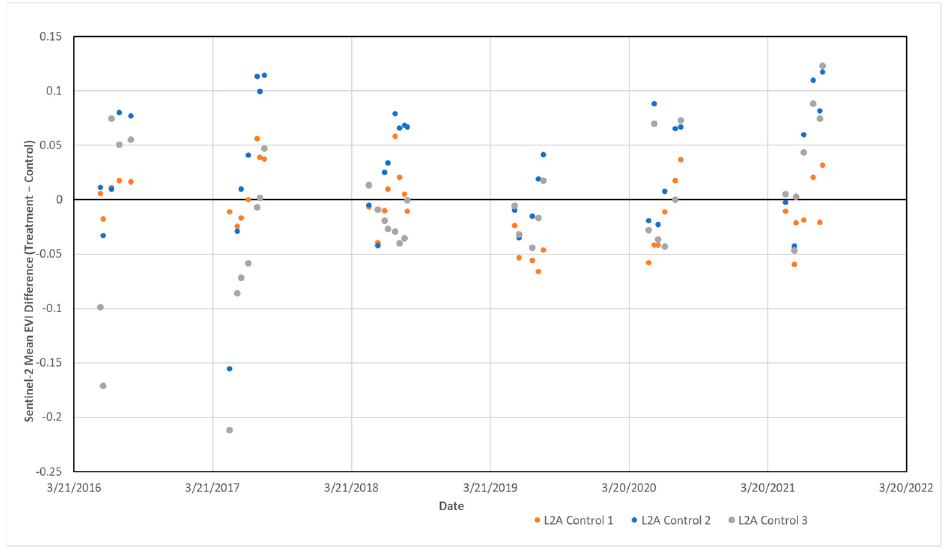
Figure 9. Sentinel-2 mean EVI difference (Treatment–Control, dimensionless) values.